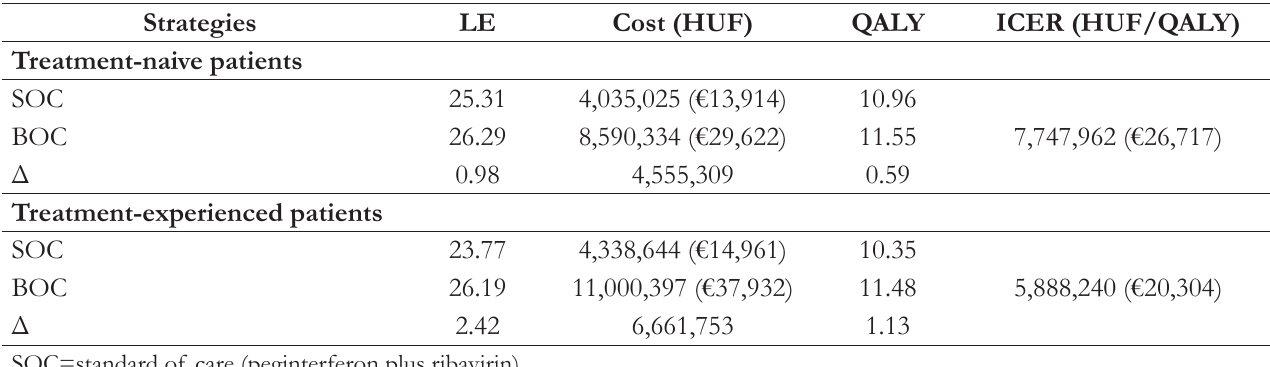
Table 7. Results